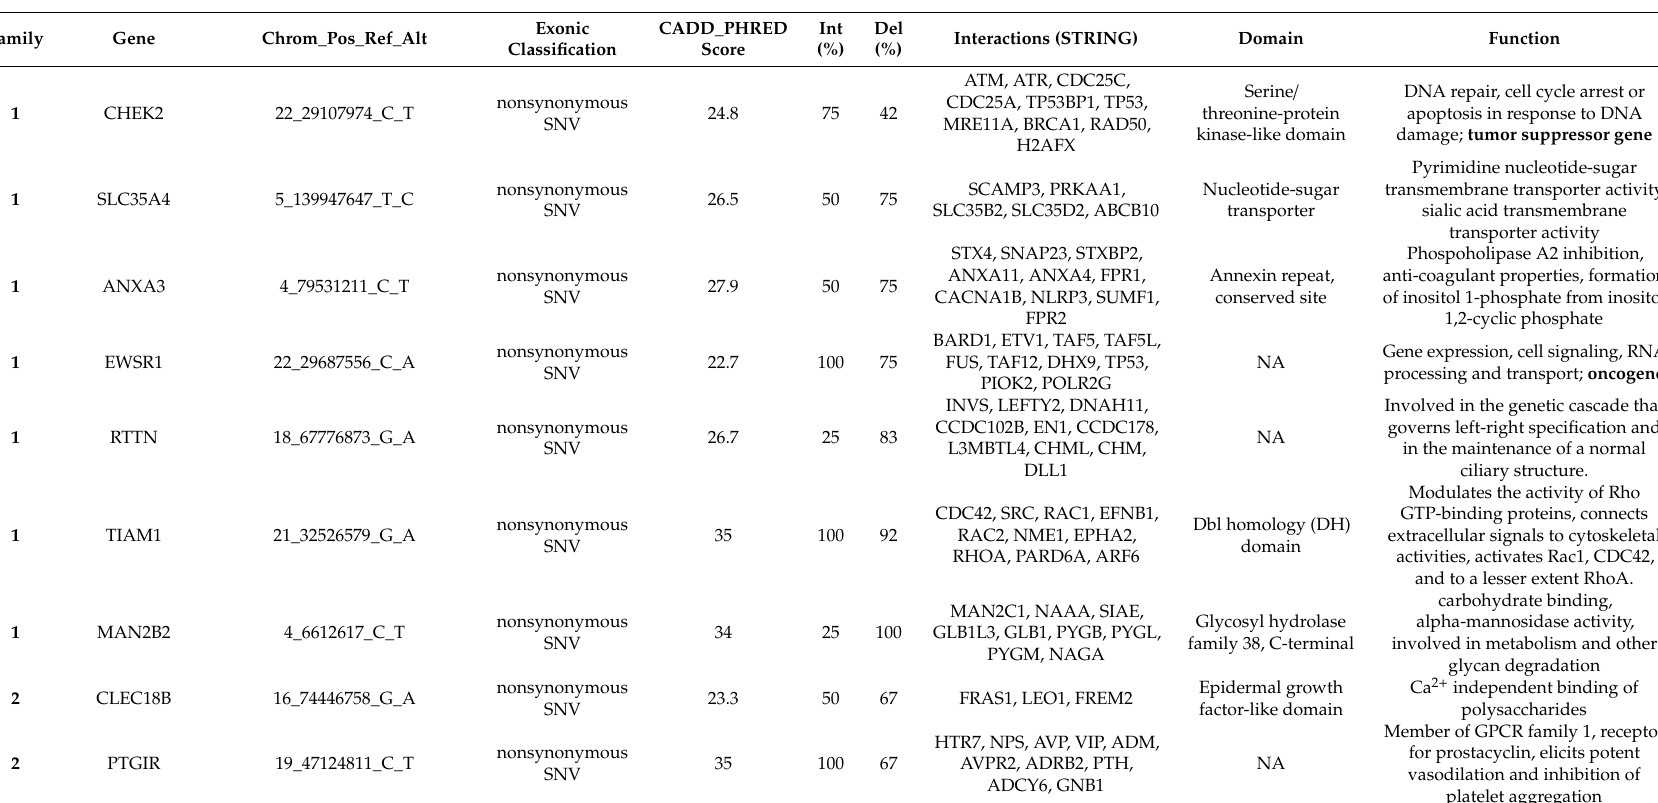
Table 1. Top exonic variants prioritized following the FCVPPv2. Chromosomal positions, classifications, PHRED-like CADD scores and the percentage of positive intolerance (Int) and deleteriousness (Del) scores are included for each variant. Additional information regarding protein-protein interactions (STRING), localization in protein domains (InterPro [37]) and the biological function of the respective protein (GeneCards [38]) is